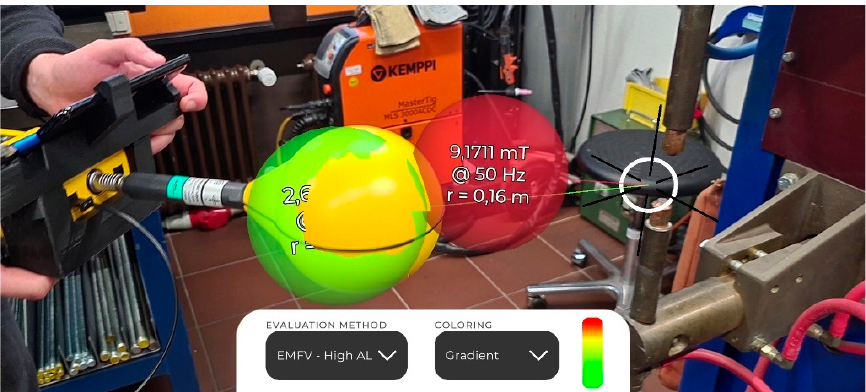
Figure 5. View of a measurement being taken as seen from the perspective of a second device. The virtual sphere representing the measurement coincides well with the measurement probe. The par- tial occlusion of the virtual sphere is possible due to the time-of-flight depth sensor in the